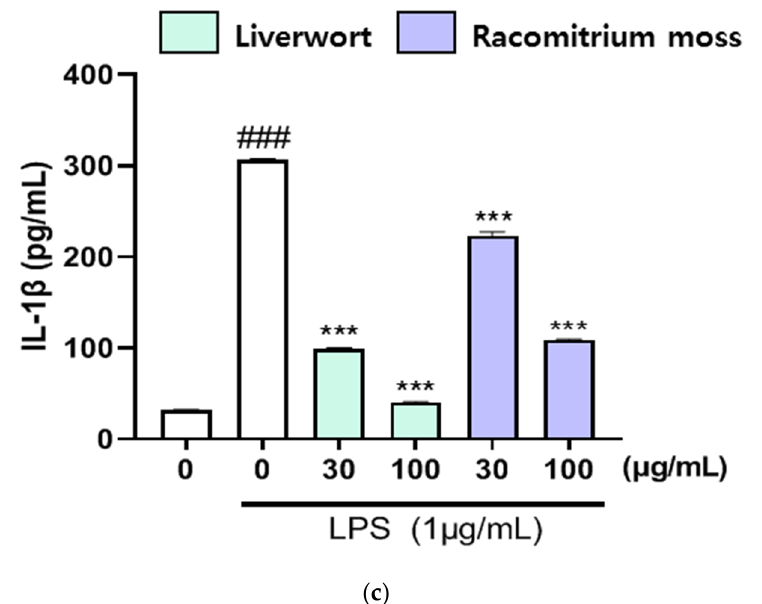
Figure 6. The effect of methanol extract of liverwort and Racomitrium moss on the level of TNF- α , IL-6, and IL-1 β in the culture medium of LPS-stimulated HaCaT cells. ( a ) the level of TNF- α ; ( b ) the level of IL-6; ( c ) the level of IL-1 β . Values are mean of three replicate determinations ( n = 3) ± standard deviation. ### p < 0.001 vs. 1% MeOH alone, ** p < 0.01, *** p < 0.001 vs. LPS alone.